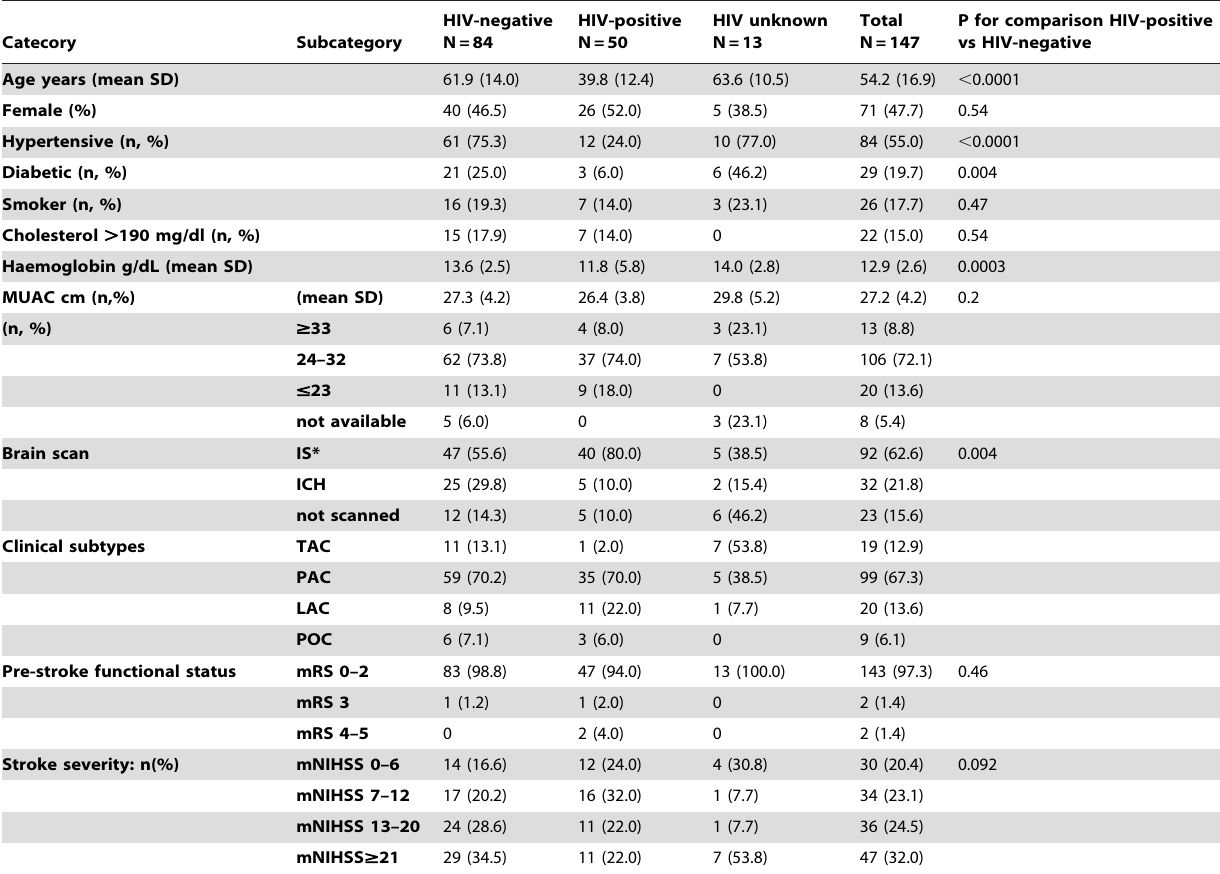
Table 1. Baseline clinical